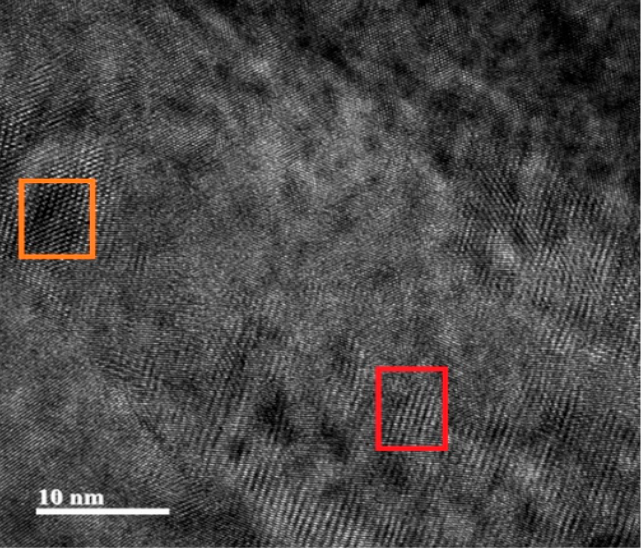
Figure 6. TEM image of the HfCN coating.